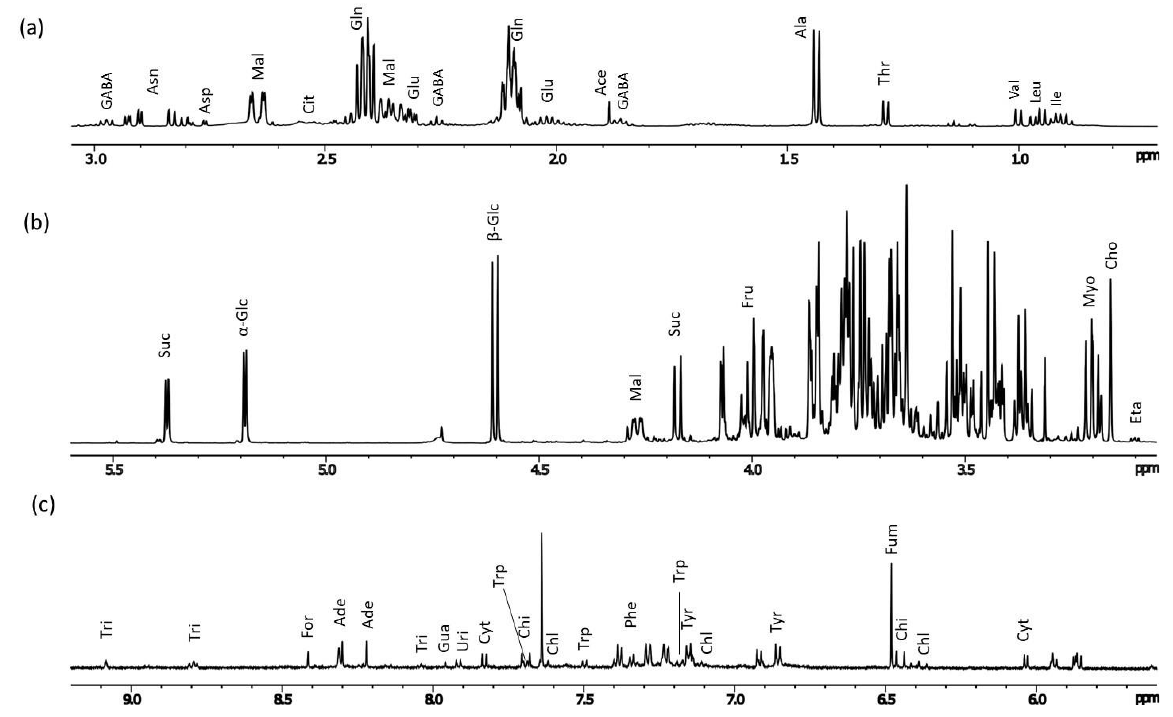
Figure 4. 1 H-NMR spectra in deuterium oxide (D 2 O) at 600 MHz of L. sativa leaves extracts (control plant) showing the identified metabolites: ( a ) spectral region from 0.7 to 3.0 ppm; ( b ) spectral region from 3.1 to 5.5 ppm; ( c ) spectral region from 5.6 to 9.5 ppm vertically expanded.